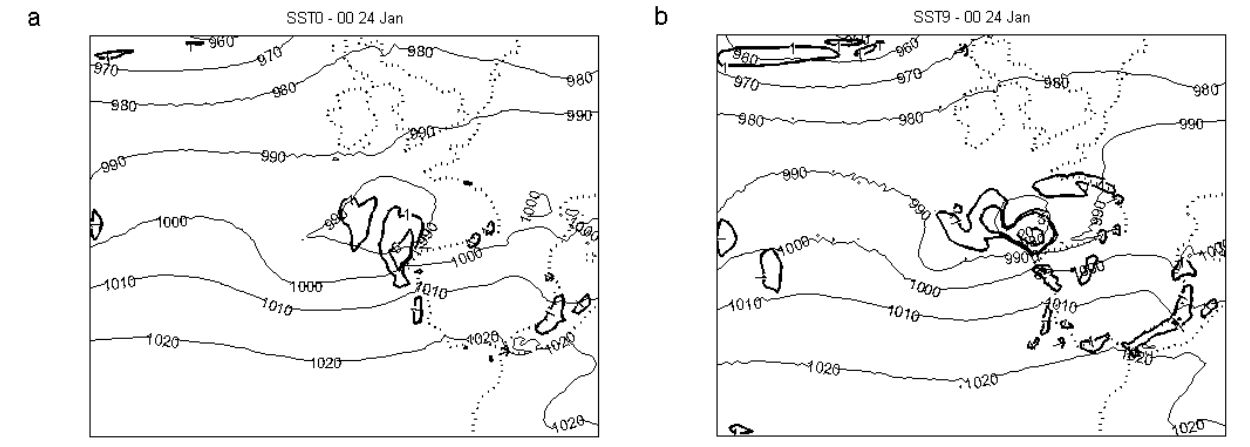
Figure 10. The contribution of W [ mm h -1 ] to the moisture convergence (Equation 1) at 00 UTC 24 for experiments SST0 (a) and SST9